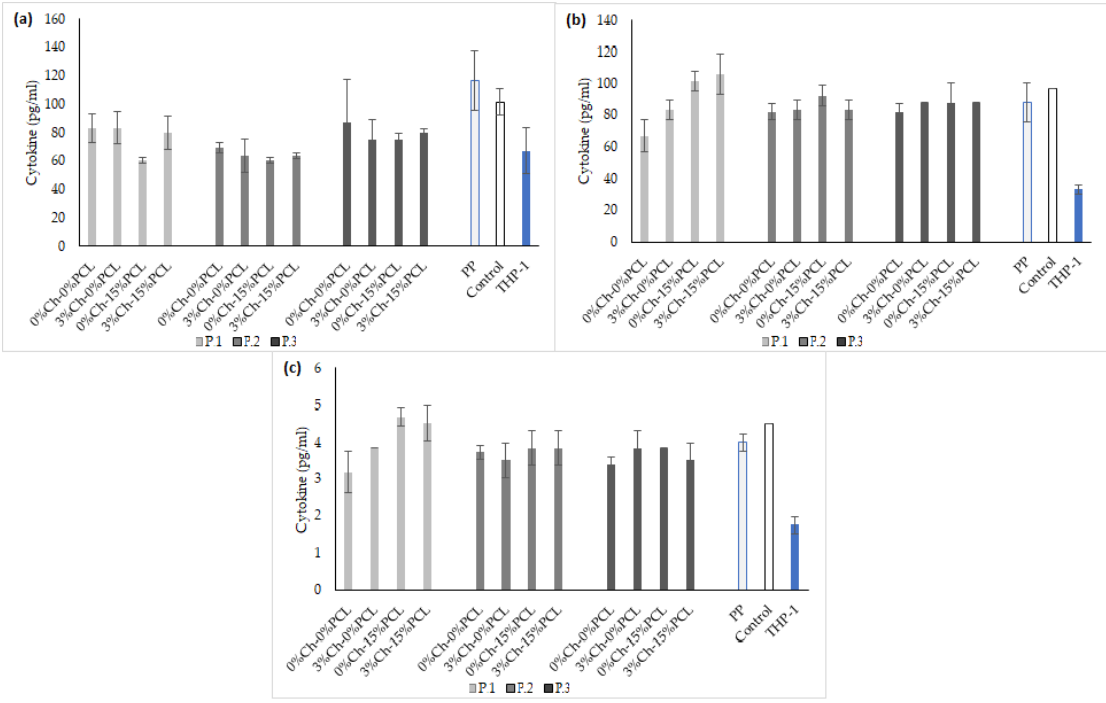
Figure 17. Anti-inflammatory cytokines with LPS stimulation. ( a ) IL-10; ( b ) IL-5; ( c ) IL-4. PP: polypropylene as a reference material; Control: culture medium without PUs; THP-1: monocyte cell line. The concentration of cytokines is expressed as the mean ± SD (n = 3).